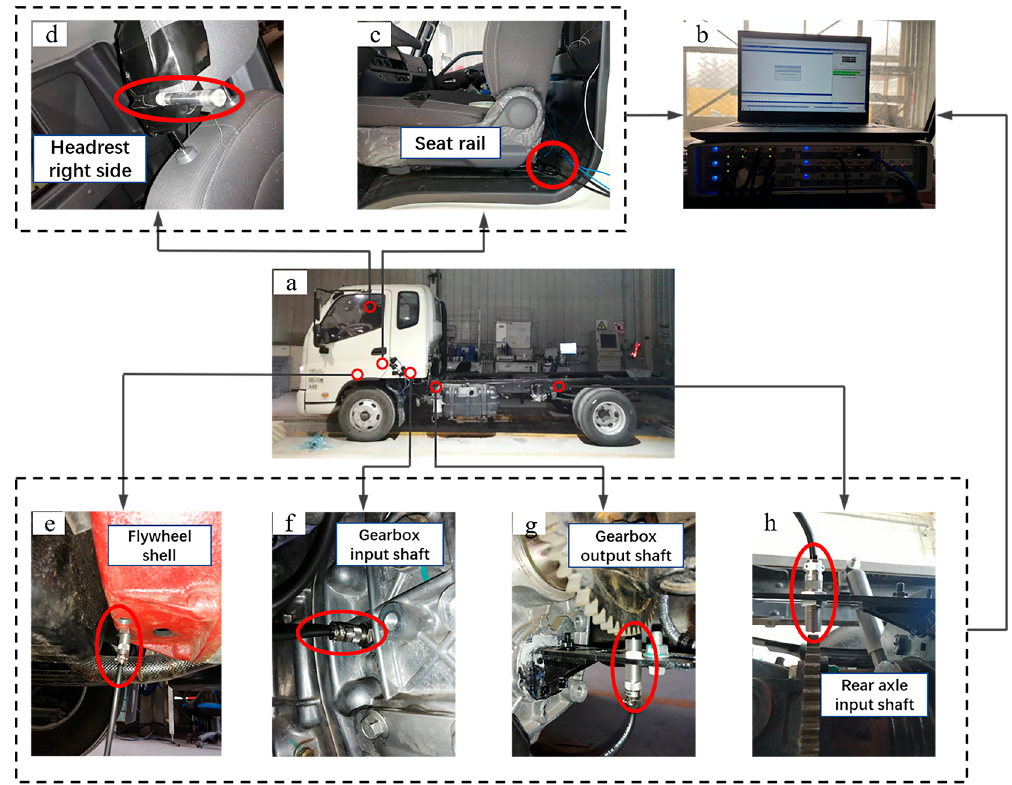
Figure 5. Layout of sensors and equipment in the experiment. ( a ) Tested vehicle; ( b ) laptop and LMS SCADAS system; ( c ) acceleration sensor; ( d ) microphone; ( e – h ) magnetic sensors for measuring speed.